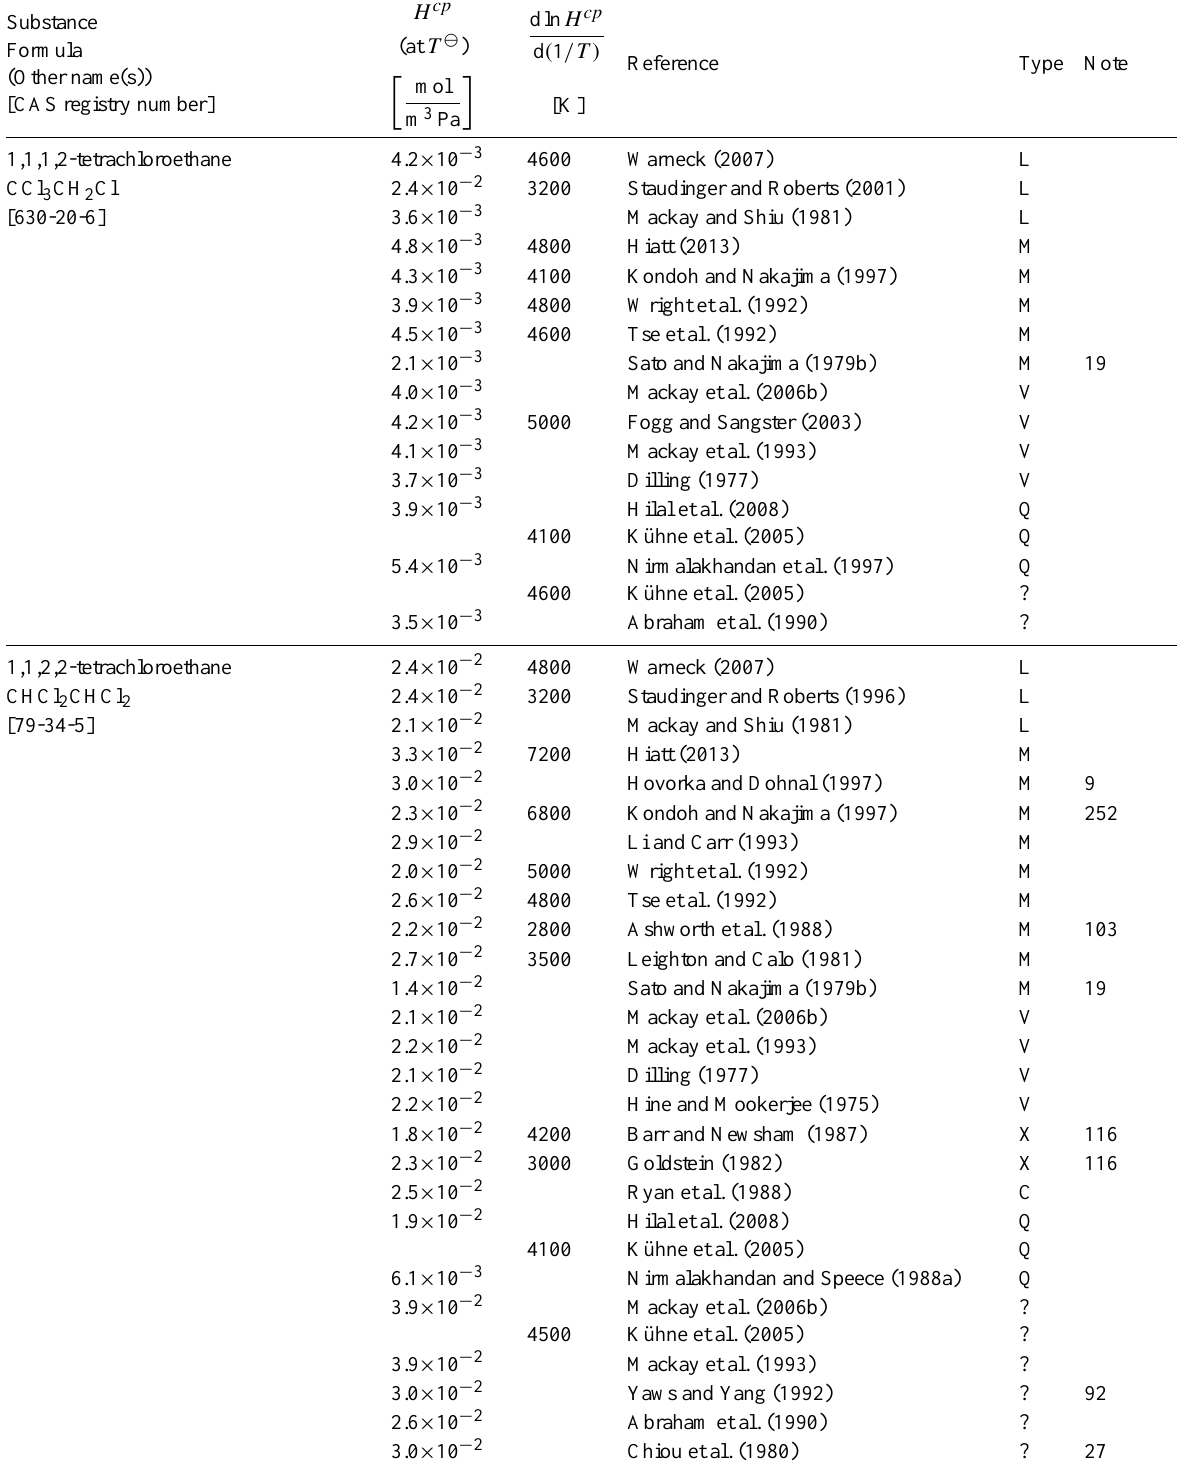
Table 6: Henry’s law constants for water as solvent